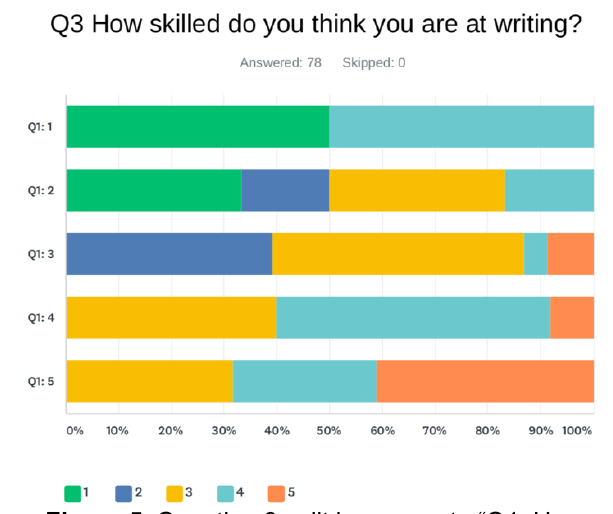
Figure 5. Question 3 split by scores to “Q1. How much experience do you have with writing overall, on a scale of 1-5, with 5 being the highest?”